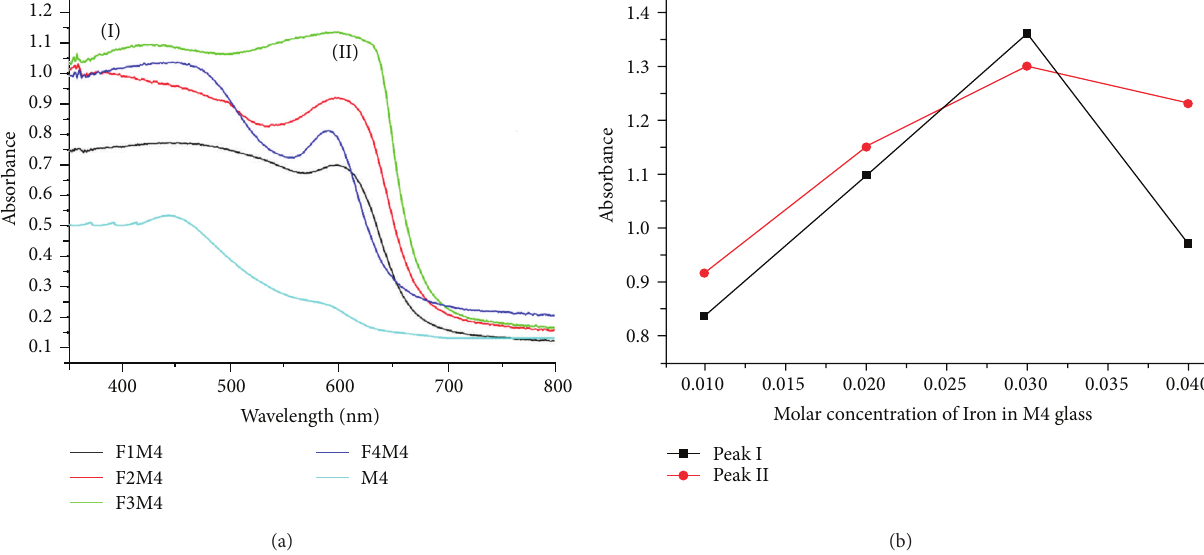
Figure 4: (a) Absorption spectra of Fe-MG SiO 2 glasses (F1M4, F2M4, F3M4, and F4M4) and M4 glass. (b) Variation of absorbance with molar concentration of Fe-I in F 𝑥 M4 glasses ( 𝑥 = 1 – 4